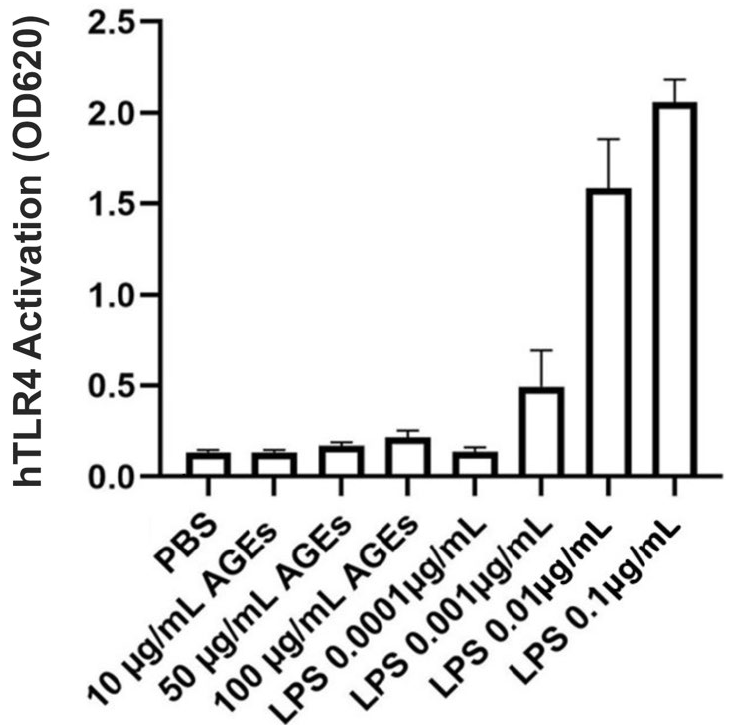
Figure 4. BioVision AGE-BSA Exhibited Little TLR4-Stimulating Activity. HEK-Blue hTLR4 reporter cells were incubated with the indicated concentrations of BioVision AGE-BSA or LPS (as a positive control), and TLR4 activation was measured as a change in absorbance at 620 nm after 24 h. Results represent the means ± SEM of four independent experiments performed in duplicate.